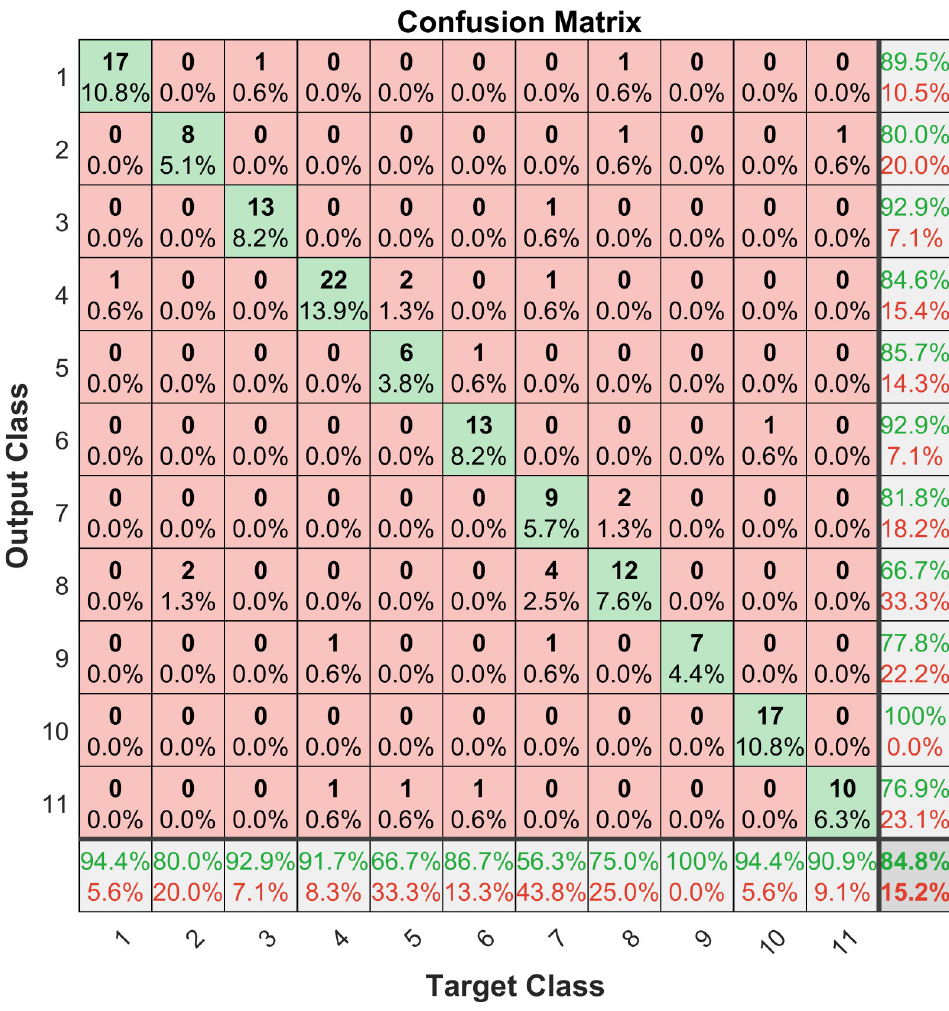
Fig 7. Confusion matrix for Cornus officinalis test samples. Each row of the confusion matrix represents the predicted category, and each column represents the true category.